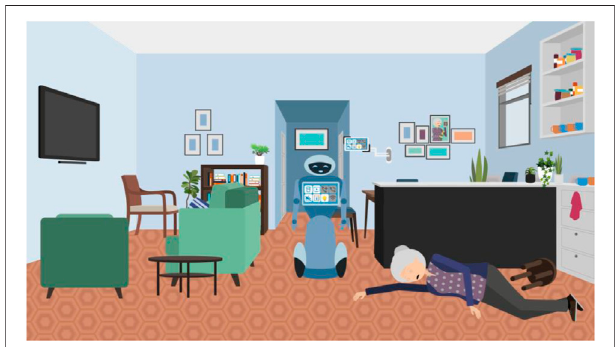
FIGURE 5 | Illustration used in VWT role-play interview showing the scene inside Rose ’ s fl